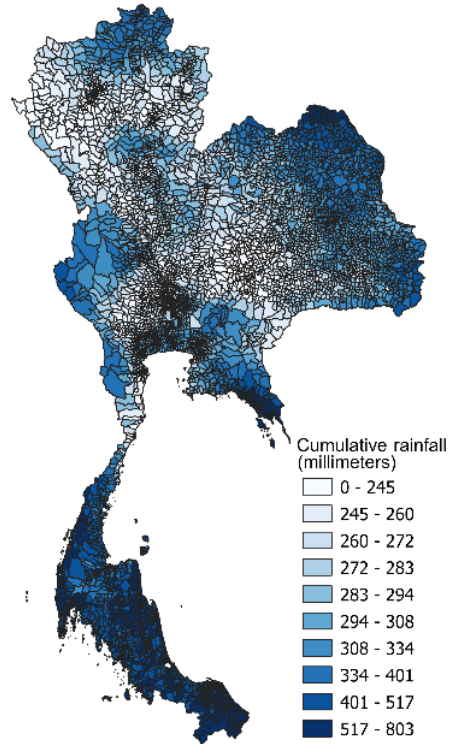
Figure 6. Spatial distribution of rainfall in 2017. Source: Google Earth Engine.